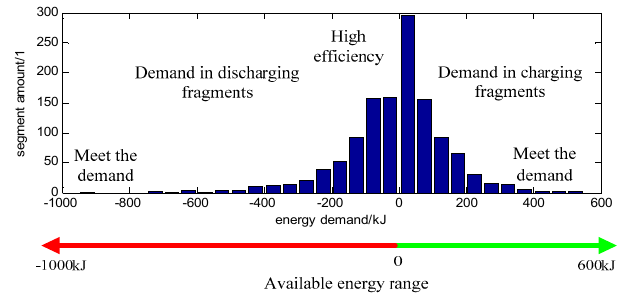
Figure 8. Energy demand of ESS.